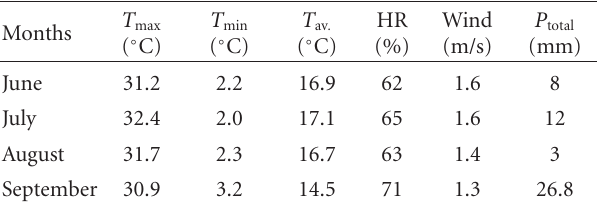
Table 2: Meteorological study of the months of June, July, August, and September 2000, with data on maximum, minimum and average temperatures, relative humidity, wind intensity, and total precipitation registered.